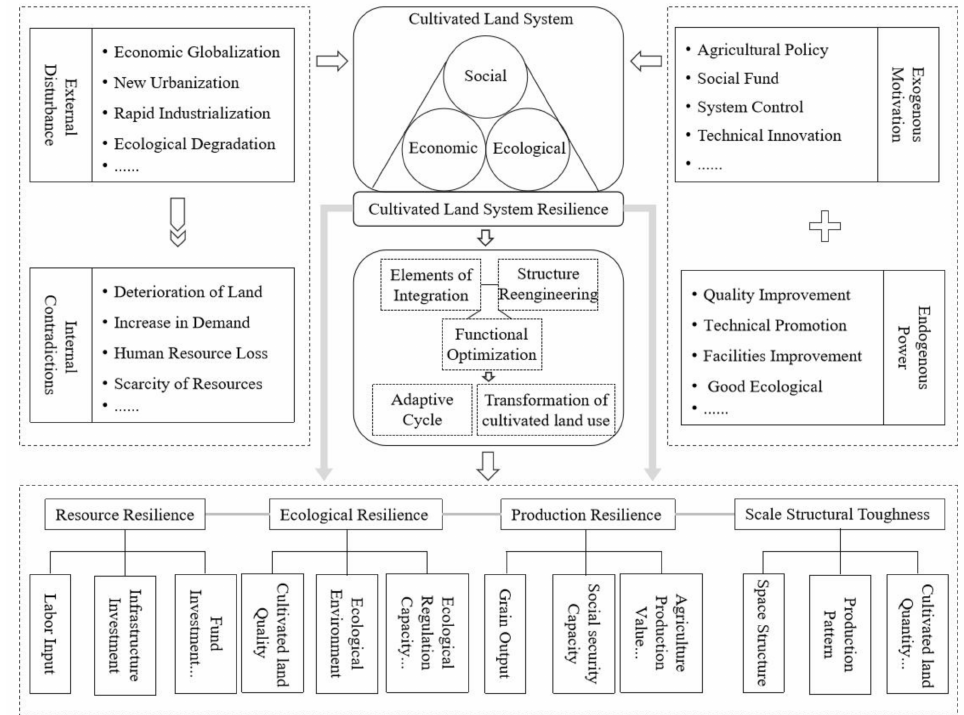
Figure 1. Cultivated land use system resilience (CLSR) composition and its logical